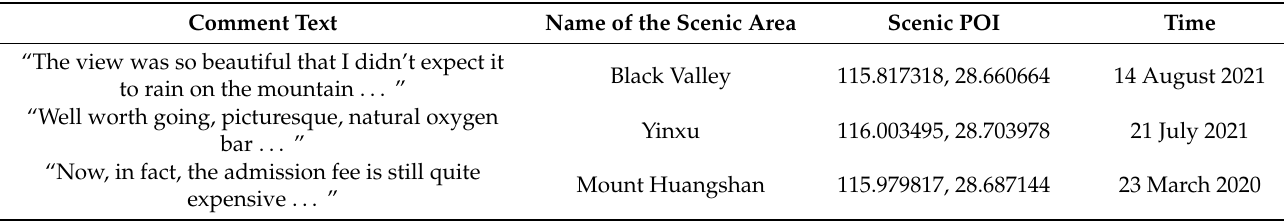
Table 1. Example of study sample